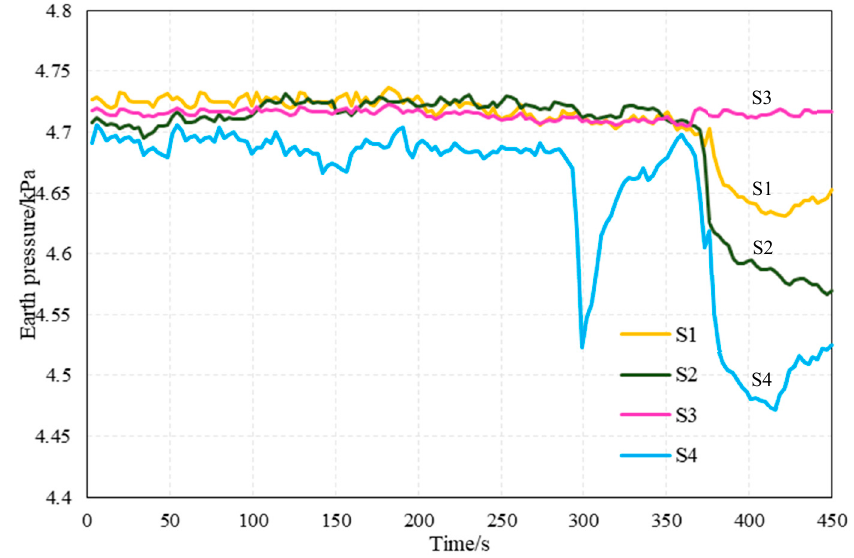
Figure 16. Measured soil pressure in Model 20-5.